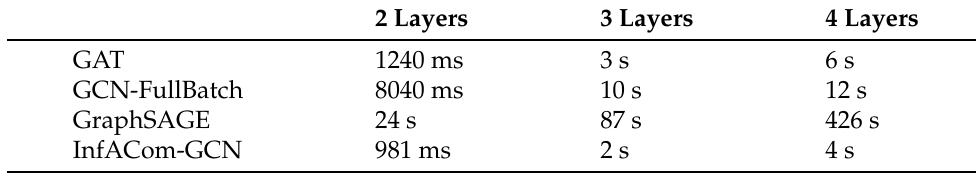
Table 7. Average time of 50 epochs for PubMedDiabetes dataset using 2, 3, and 4 layers (the number of hidden units is 128).